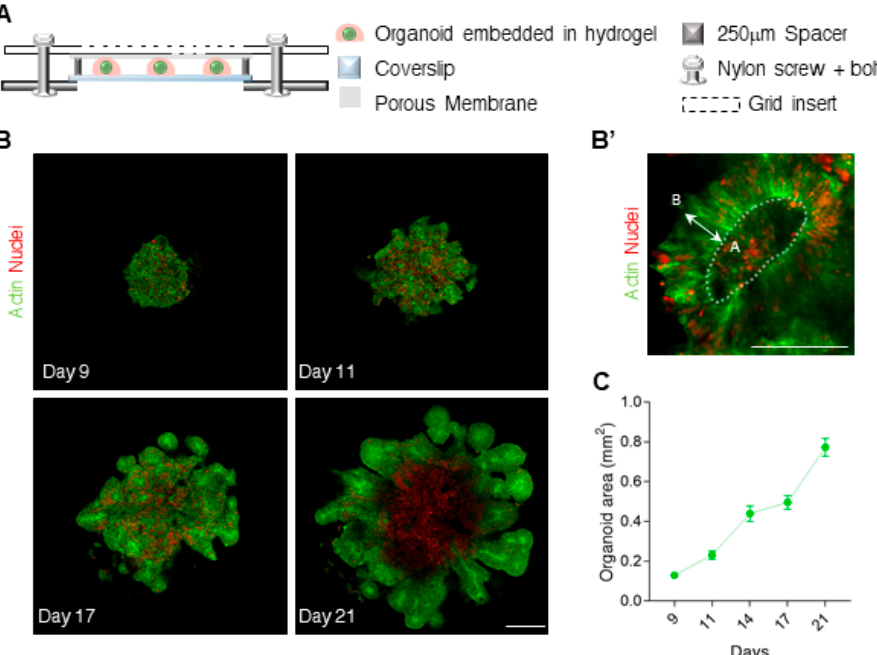
Figure 1. Live imaging of Neuroepithelium organoids grown on chip. ( A ) An illustration of the assembled organoid compartment (side view), consisted of a removable grid insert with a membrane (top), a spacer (h = 250 mm) and a glass coverslip (bottom). ( B ) Fluorescent images showing the development of a human brain organoid, and the emergence of neural epithelium (NE) centers. The cells are labeled with a membranal marker (LifeAct-GFP, Green) and with a nuclear marker (H2B-mCherry, Red). ( B’ ) Enlarged image of a NE center. Dashed line marks the inner / apical (A) surface. The cells within the NE are starched between the outer / basal ( B ) and the apical side. Cell divisions occur on the apical side. ( C ) Organoid area (mm 2 ) over time. N = 32 organoids. Scale bars 200 µ m. Error bars represent ± SEM.